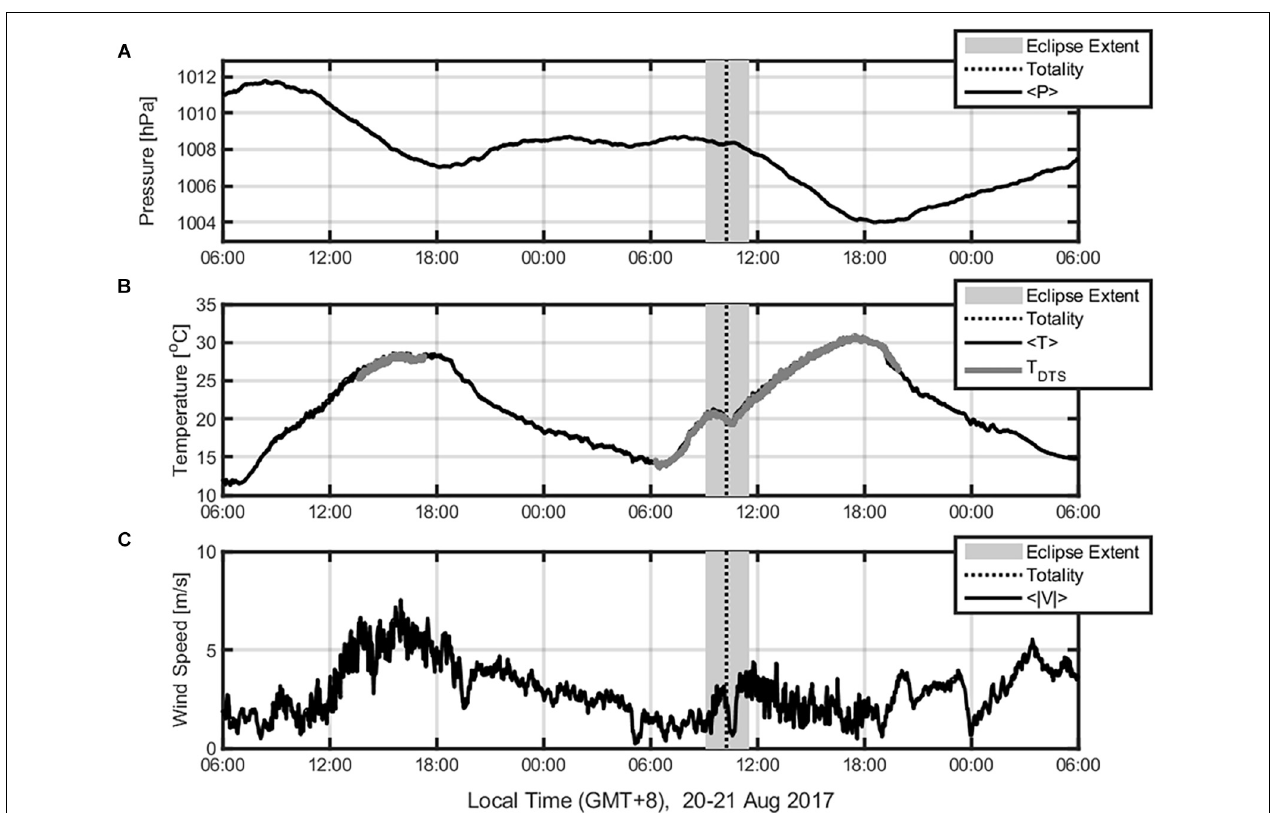
FIGURE 3 | Time series of the 2-min STE mean pressure (A) , temperature (B) and wind speed (C) at 3 m elevation through the observation period from the sensor array, and the 2-min mean DTS temperature at the 3-m (a.g.l.) fiber-optic range gate. Sunrise occurred at 06:22 and sunset at 20:08 local